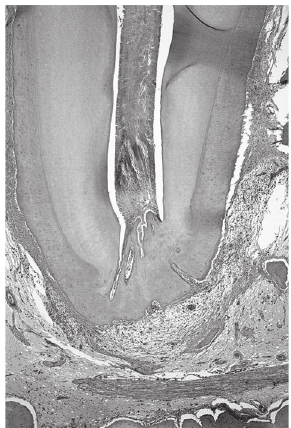
Figure 3. Group I (collagen). Root apex with evident areas of cementum resorption. Severely widened periodontal ligament space, with the presence of inflammatory infiltrate. HE; magnification,